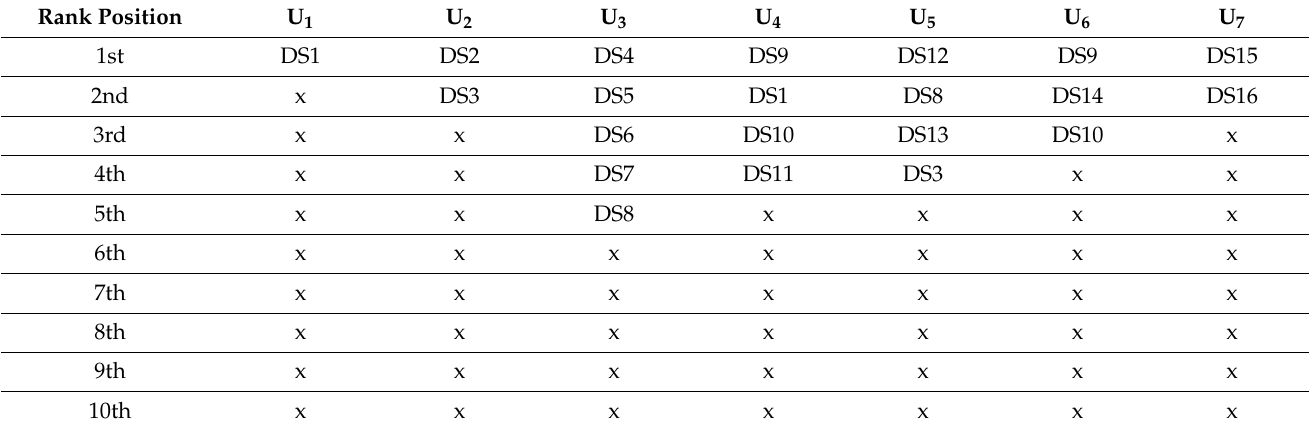
Table 3. Ranking of books on Data Structure by top universities.